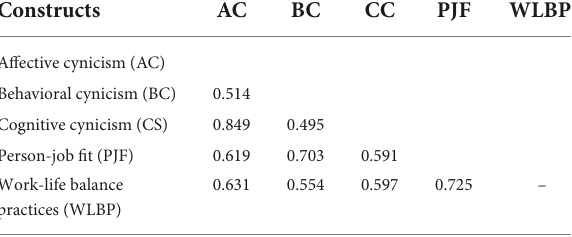
TABLE 4 Heterotrait-Monotrait Ratio